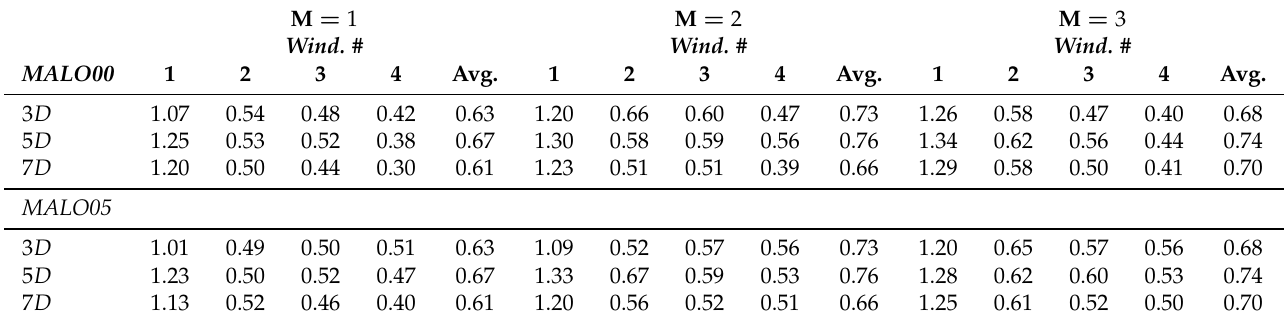
Table A2. Standard deviations of cavity side Nusselt number for each of the averaged data points ( imp area) shown in Figure A1. M = 1 M = 2 M = 3 Wind. # Wind. # Wind. #